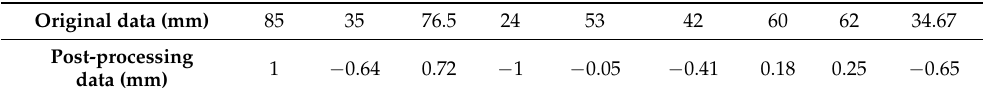
Table 4. Normalized Data